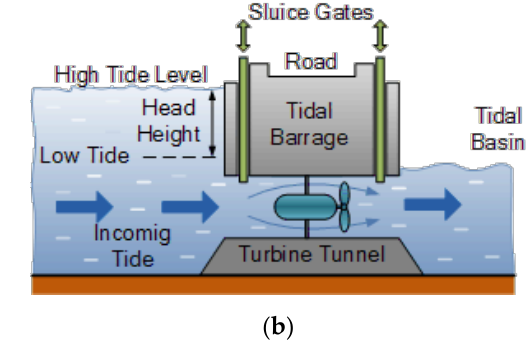
Figure 6. Ebb generation ( a ) and flood generation ( b ) plant scheme.